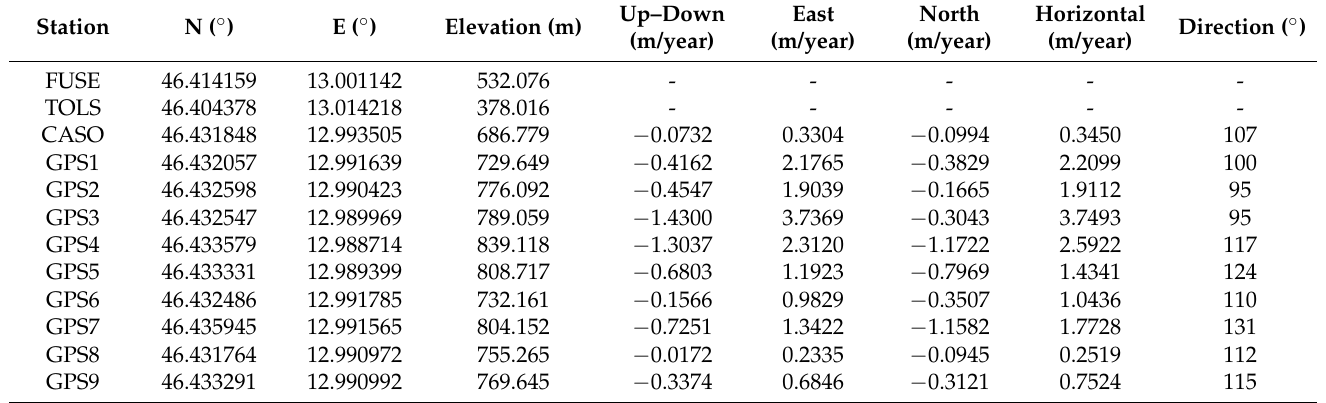
Figure 4. ( a ) Displacement toward the East recorded by the cost-effective, single-frequency GNSS network on the Cazzaso landslide between 1 January 2019 and30 June 2021. The black lines with different patterns indicate the different GPS stations. The blue line indicates the cumulative meas- urement of rainfall recorded by the Tolmezzo rainfall gauge (near TOLS station); ( b ) Detailed plot of the GPS3 eastern displacement compared with the rainfall gauge values in Tolmezzo; the GPS3 hourly velocity (East component) is also included to highlight the fastest rain phenomena that had the greatest impact on GPS3’s movements.